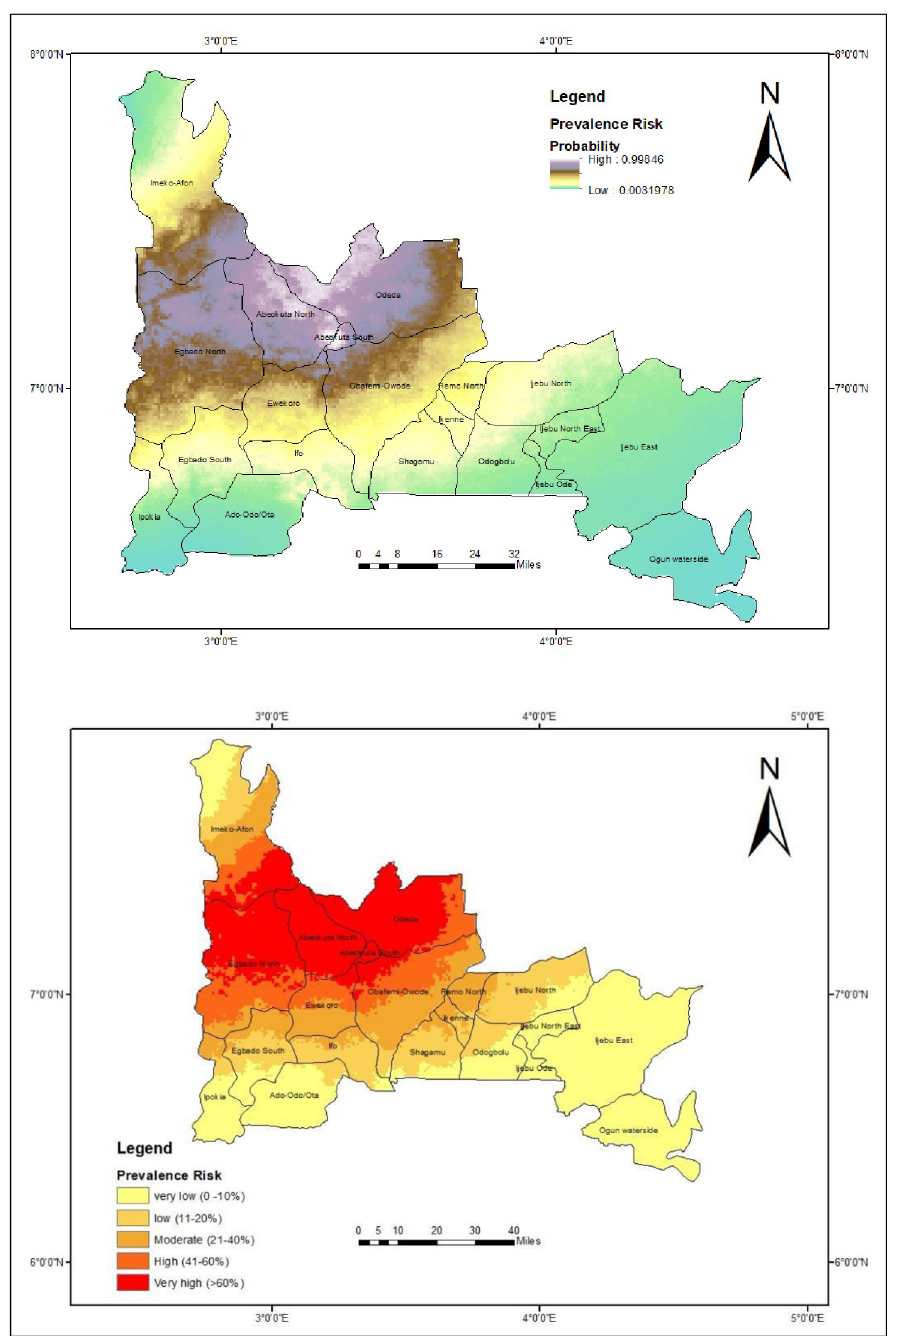
Fig 4. Predicted prevalence of O . volvulus infection in Ogun State Nigeria. This figure was created by the authors in R programming software (R version 4.1.2, Vienna, Austria). Available at https://www.R-project.org/. The Nigerian shapefile was obtained from World BankDataCatalog (https://data.humdata.org/dataset/geoboundaries-admin- boundaries-for-nigeria) an Open license standardized resource of boundaries (i.e., state, county) for every country in the